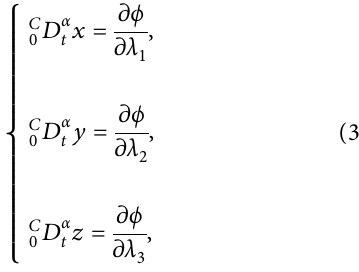
Figure 14: Dynamics of x ( t ) where a � 0 . 1 , b � 0 . 1 , c � 0 . 1 , e � 0 . 3 , f � 0 . 2 , h � 0 . 3 , i � 0 . 2 , C � 0 . 01 , A � 0 . 02 , and A A 1 2